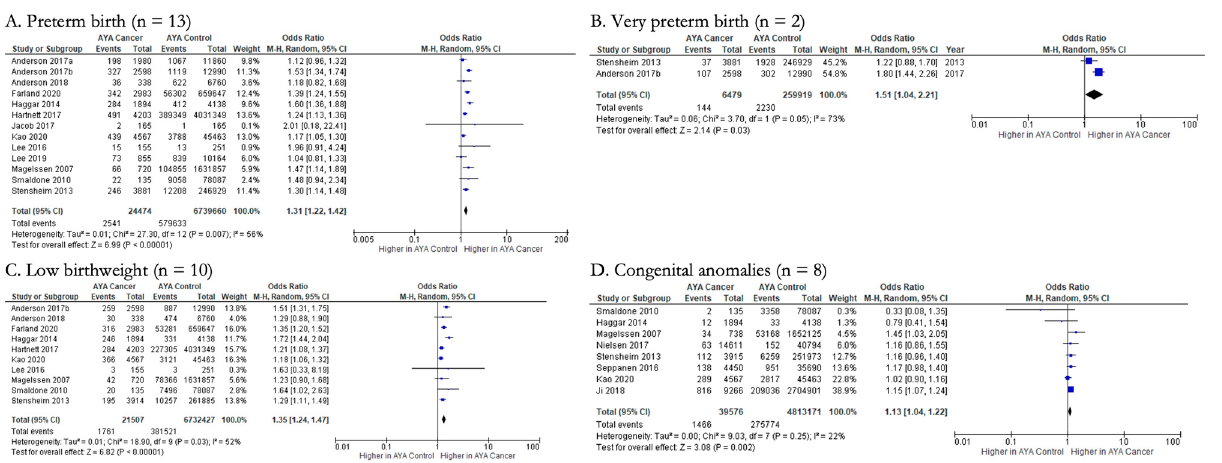
Figure 3. Forest plots for significant fetal/neonatal outcomes reported by two or more studies (n = congenital anomalies (pOR 1.13; 95% CI: 1.04, 1.22), respectively (Figure 3C,D). 4). A. [27–29,31,34–36,39,40,42–45], B. [31,42], C. [27–29,31,36,39,40,42,44,45], D. [27,29,31– 33,36,37,40].